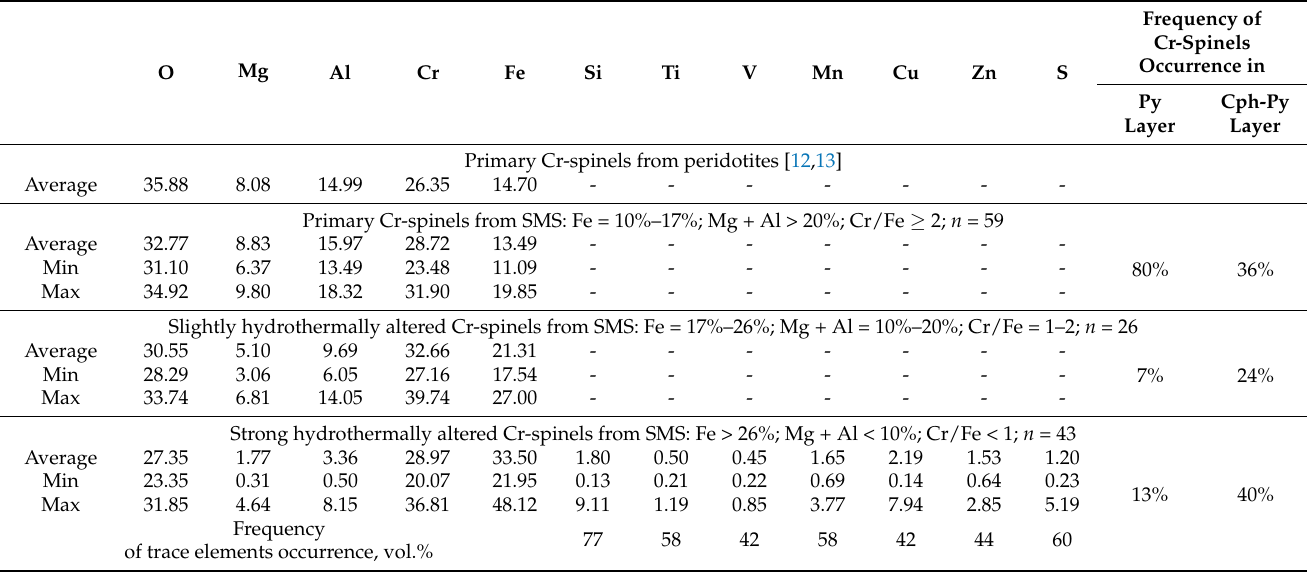
Table 5. Variations in Cr-spinels composition from st. 242 (wt